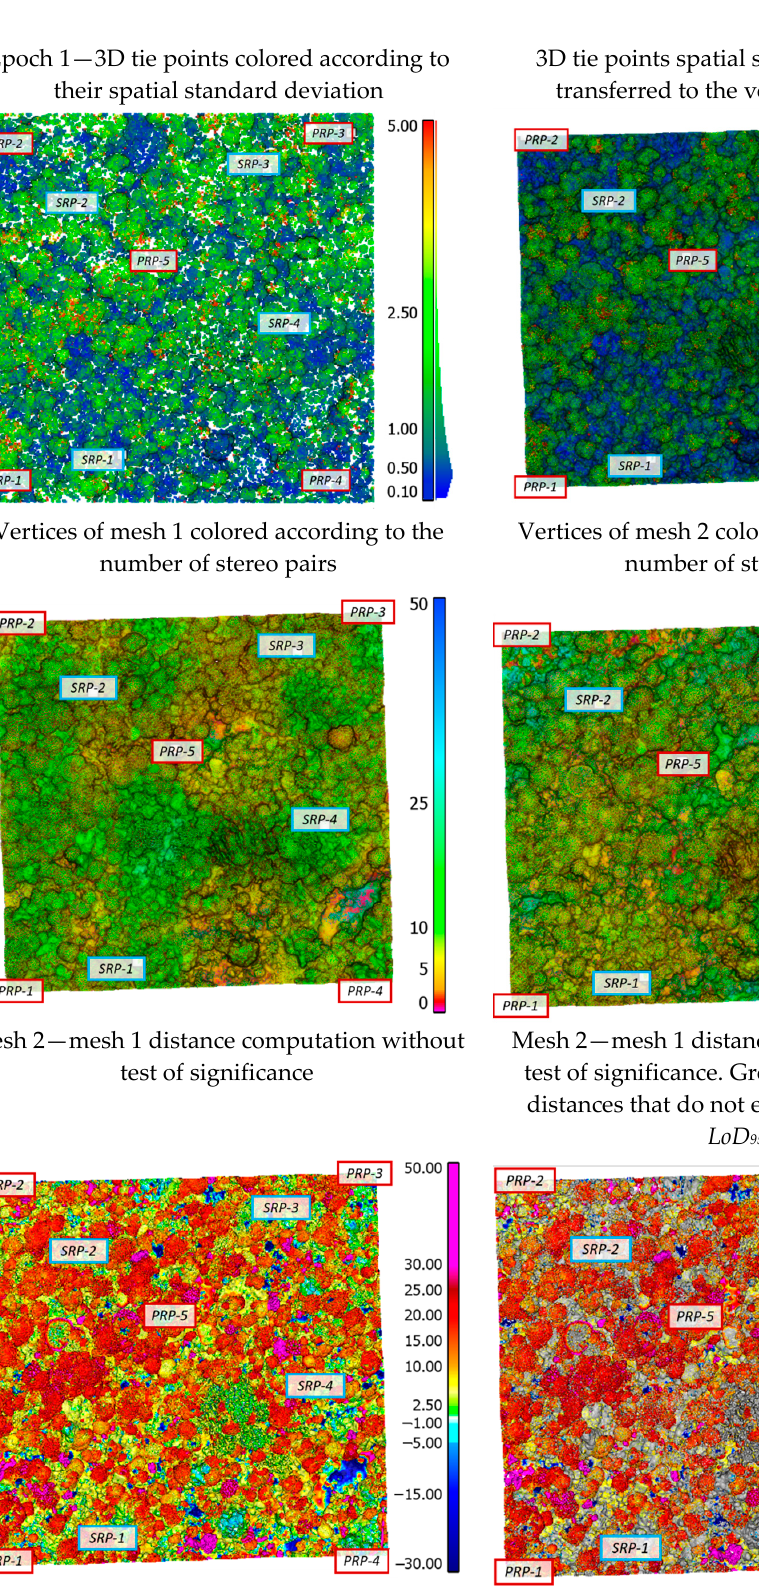
Figure 16. Details of the orthophotos for the two epochs (2018 and 2019) over the test site together with a map of the significant differences (right). 6. Conclusions and Future Developments